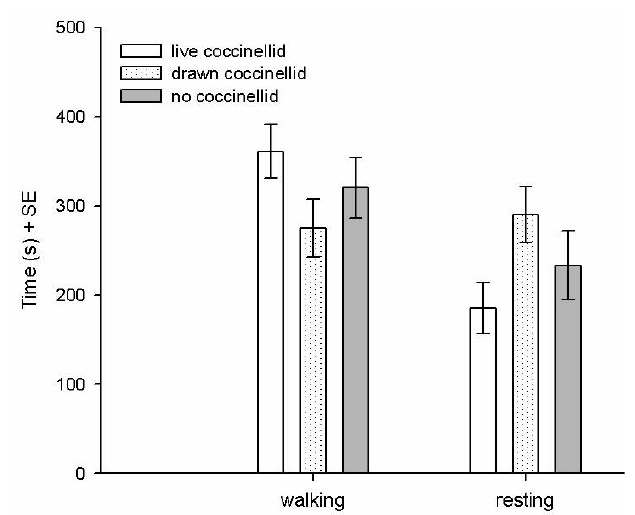
Fig 3. Total time spent walking and resting by Camponotus ants in three treatments: live coccinellid (scent and visual cues), drawn coccinellid (visual cue only), and no coccinellid (no predator